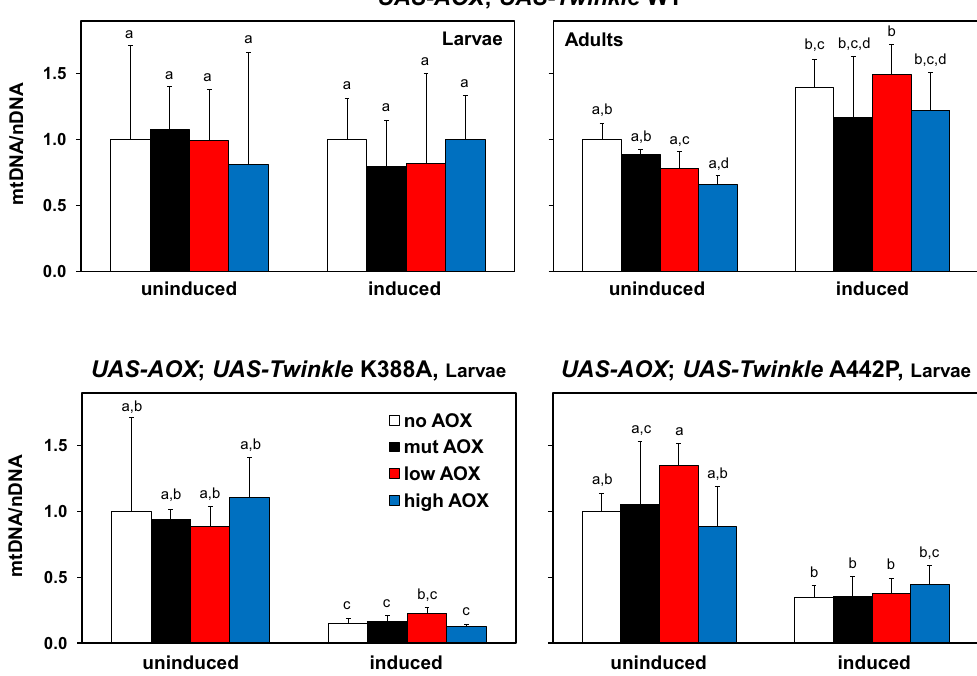
Figure 2. AOX does not interfere with mtDNA copy number in mutant Twinkle lines. Total DNA from larva and adult samples and quantitative PCR were performed as described in the Methods. Uninduced and induced indicate samples originated from the crosses UAS-AOX ; UAS-Twinkle X w 1118 and UAS-AOX ; UAS-Twinkle X daGAL4 , respectively. Relative mtDNA copy number (mtDNA/nDNA) was normalized by the mean 2 −ΔΔ CT of control samples from the crosses UAS-empty 2nd ; UAS-Twinkle X w 1118 in every panel. no AOX, mut AOX, low AOX and high AOX indicate respectively the constructs UAS-empty 2nd , UAS-mutAOX 2nd , UAS-wtAOX 8 . 1 21 and UAS-wtAOX F6 12 . Letters a-d indicate significantly different statistical classes ( P < 0.05) according to one-way ANOVA, followed by the Tukey post-hoc test, applied separately for the data in each